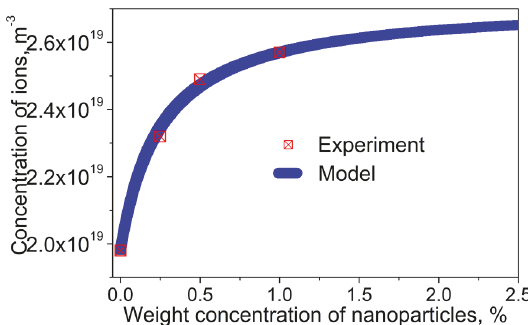
Figure 1: Liquid crystals doped with nanoparticles: the ion density Figure 2: The concentration of ions in liquid crystals doped with as a function of the weight concentration of nanodopants, 𝜔 𝑁𝑃 . The TiO 2 nanoparticles as a function of the weight concentration of nan- case of 100% pure ( ] 𝑁𝑃 = 0 ) nanoparticles in liquid crystals is odopants. The presented model (solid curve) is in good agreement represented by dashed-dotted curve (ion trapping regime). Different with reported experimental data points (squares) [34]. Physical regimes of contaminated nanoparticles in liquid crystals are also parameters used in simulations: 𝜎 𝑁𝑃 𝑆 = 0.8 × 10 18 𝑚 −2 , 𝐾 𝑁𝑃 = shown: ion generation (or ion releasing) regime (dashed curve, 1.6×10 −23 𝑚 3 , 𝑛 = 1.98×10 19 𝑚 −3 , ] = 4.35×10 −4 , 𝑅 = 25 𝑛𝑚 , 0 𝑁𝑃 𝑁𝑃 ] = 1.5 × 10 −3 ); ion trapping (or ion capturing) regime (solid 𝑁𝑃 and 𝜌 𝑁𝑃 /𝜌 𝐿𝐶 = 3.9 curve, ] 𝑁𝑃 = 3×10 −4 ); no change regime (dotted curve, ] 𝑁𝑃 = ] 𝐶 𝑁𝑃 = = 10 18 𝑚 −2 , 8 × 10 −4 ). Physical parameters used in simulations: 𝜎 𝑁𝑃 𝑆 = 𝑘 𝑁𝑃 /𝑘 𝑁𝑃 = 2 × 10 −23 𝑚 3 , 𝑛 = 4 × 10 19 𝑚 −3 , 𝑅 = 10𝑛𝑚 , 𝐾 𝑁𝑃 0 𝑁𝑃 𝑎 𝑑 and 𝜌 𝑁𝑃 /𝜌 𝐿𝐶 = 3.9 .